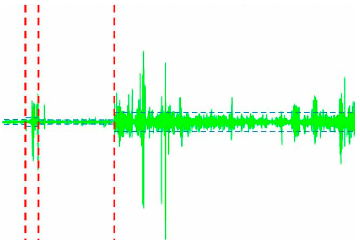
Figure 13. Sample thresholding in the denoising process for the d1 coefficient.